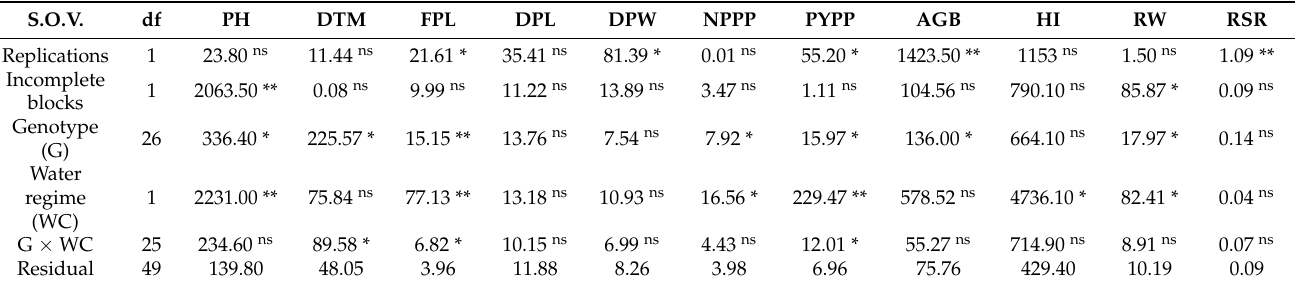
Table 4. Analysis of variance showing mean square values and significant tests of 26 okra accessions assessed for phenotypic responses in glasshouse environment under drought-stressed (DS) and non-stressed (NS)